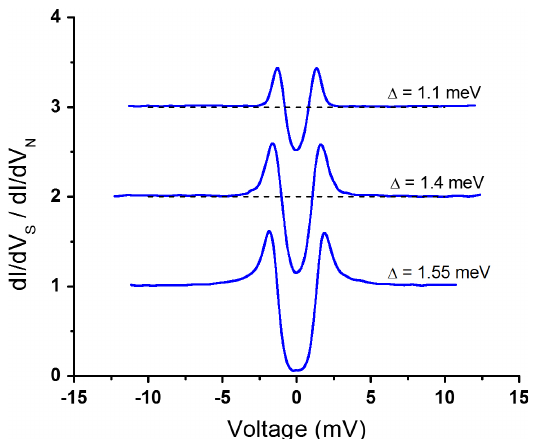
FIG. 18. Typical tunneling spectra obtained for different junc- tions on sample L46 offset vertically for clarity. This sample had a broad range of gap values with values of 1.10 and 1.47 meV being the most common. Junctions with gaps closer to the bulk value for Nb showed large coherence peaks (small (cid:3) ). However, this decreased considerably for gap values smaller than about 1.4 meV.